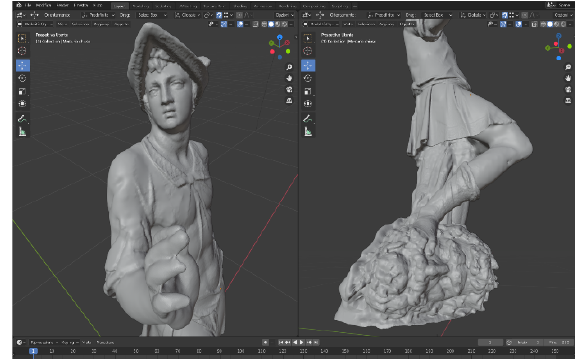
Figure 20. Mesh of Mercury in the Blender